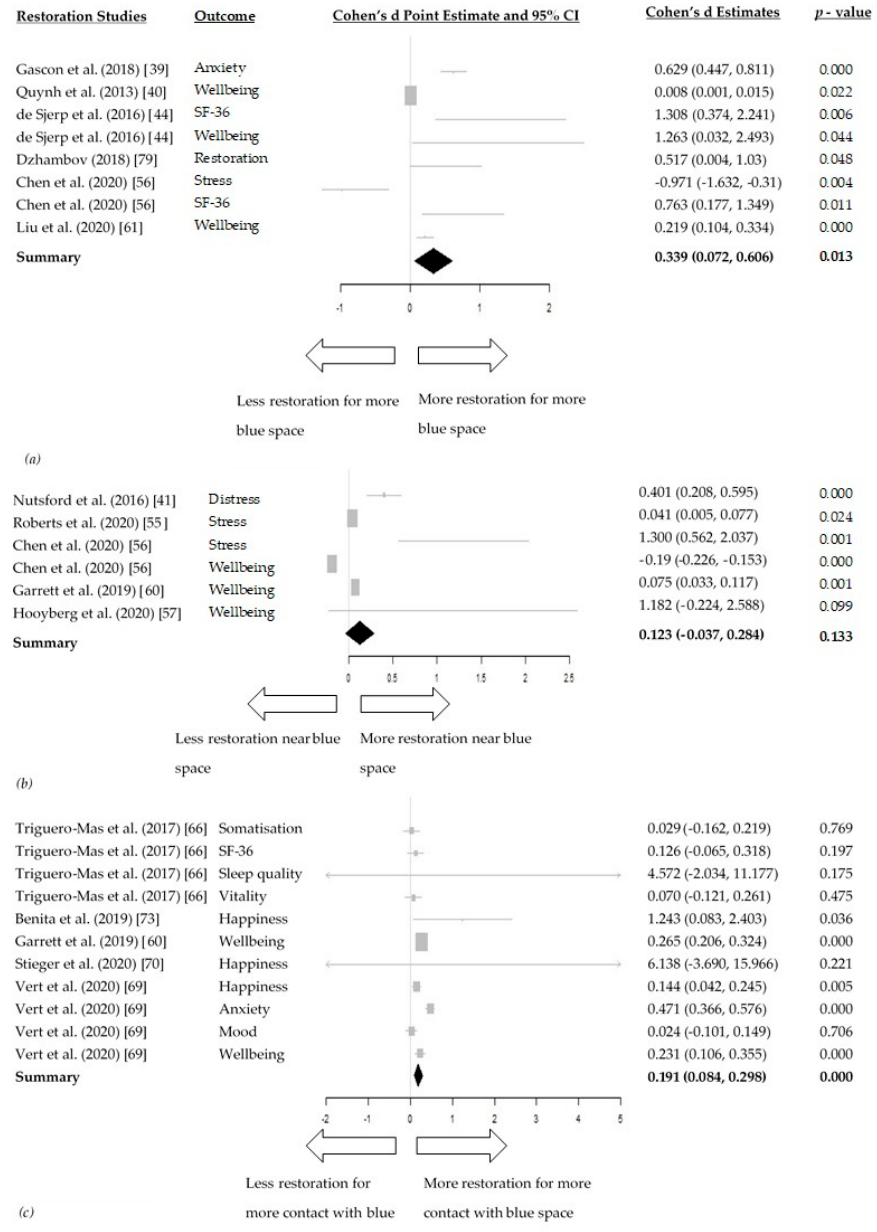
Figure 4. ( a ) Forest plot of the relationship between the amount of blue space within a geograph- ical area and restoration; ( b ) Forest plot of the relationships between distance to blue space and restoration; ( c ) Forest plot of the relationship between contact with blue space and restoration.